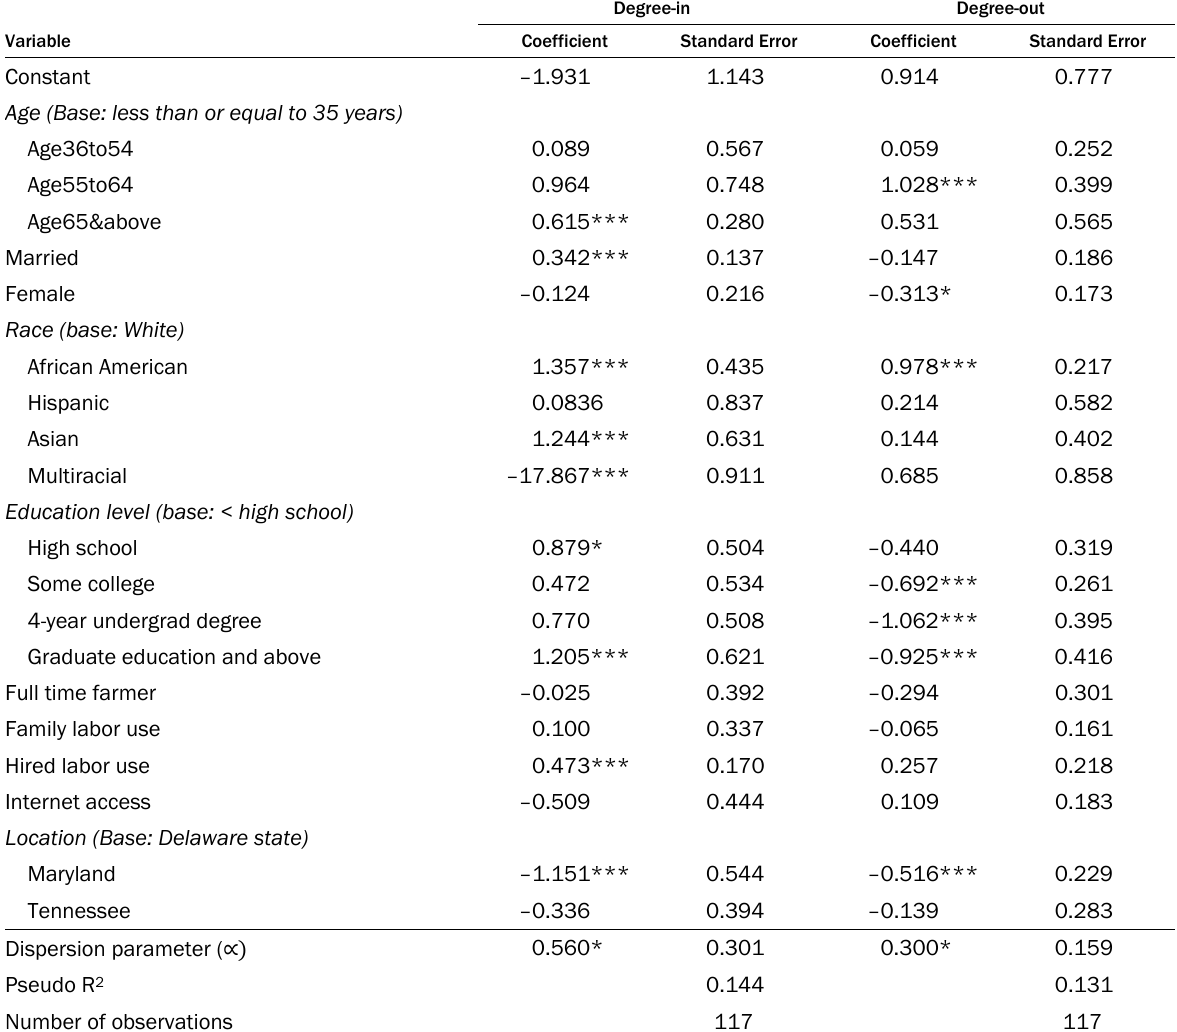
Table 3. Factors Influencing Network Centrality